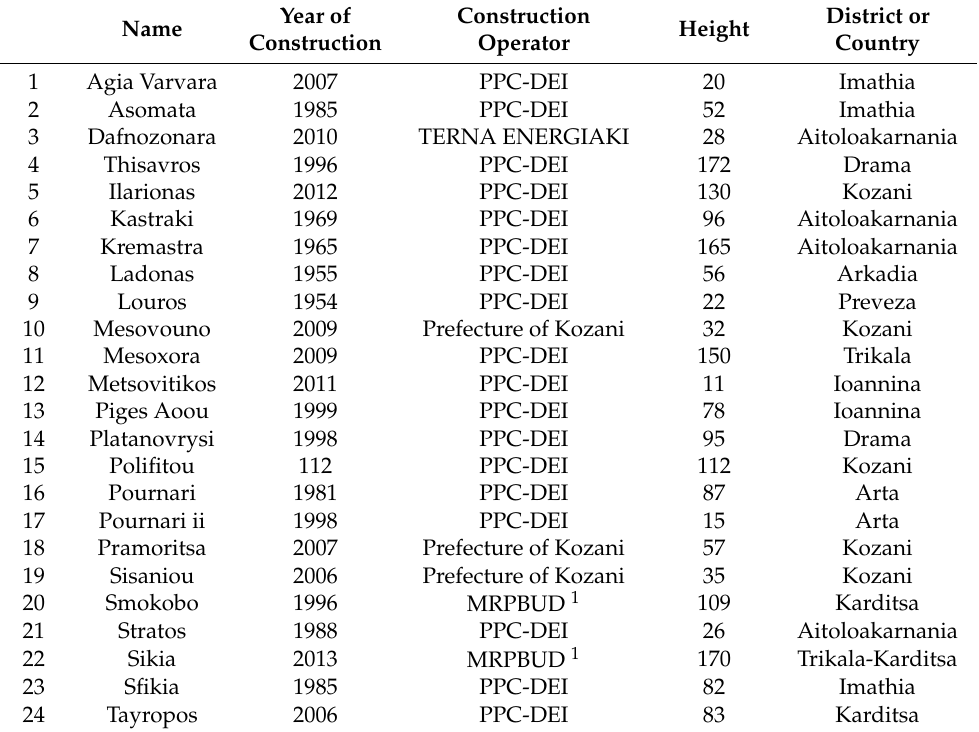
Table 1. List of large Greek dams for the purpose of electricity generation based on data of Hellenic Committee of large